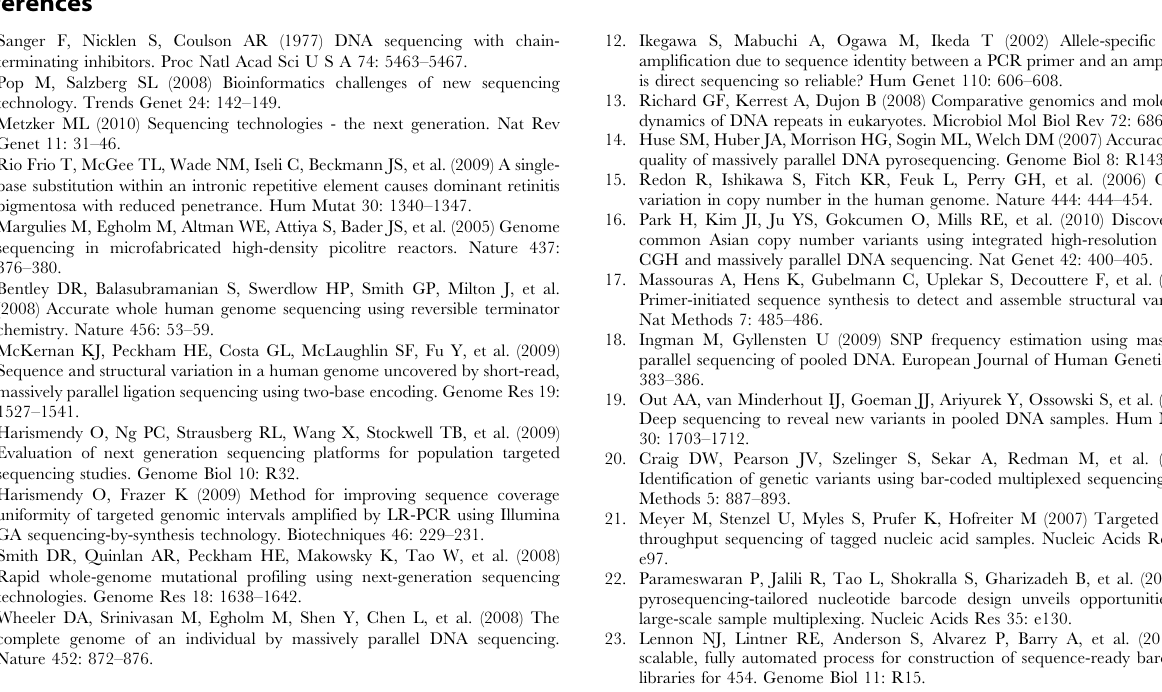
Table S2 Details on false positive results detected, after assembly of untrimmed reads.